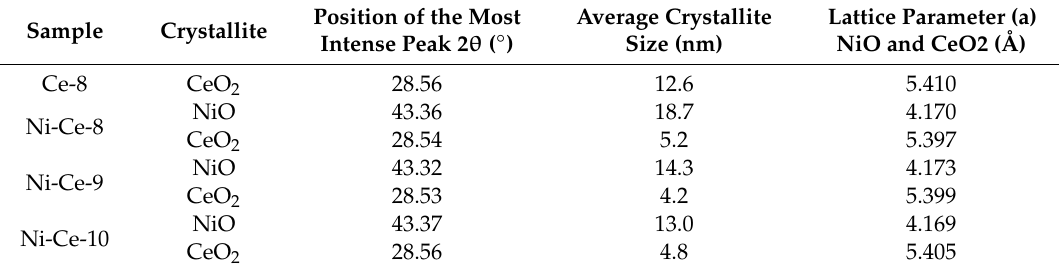
Table 2. Results obtained from the structural characterization of Ni–Ce catalysts by XRD.